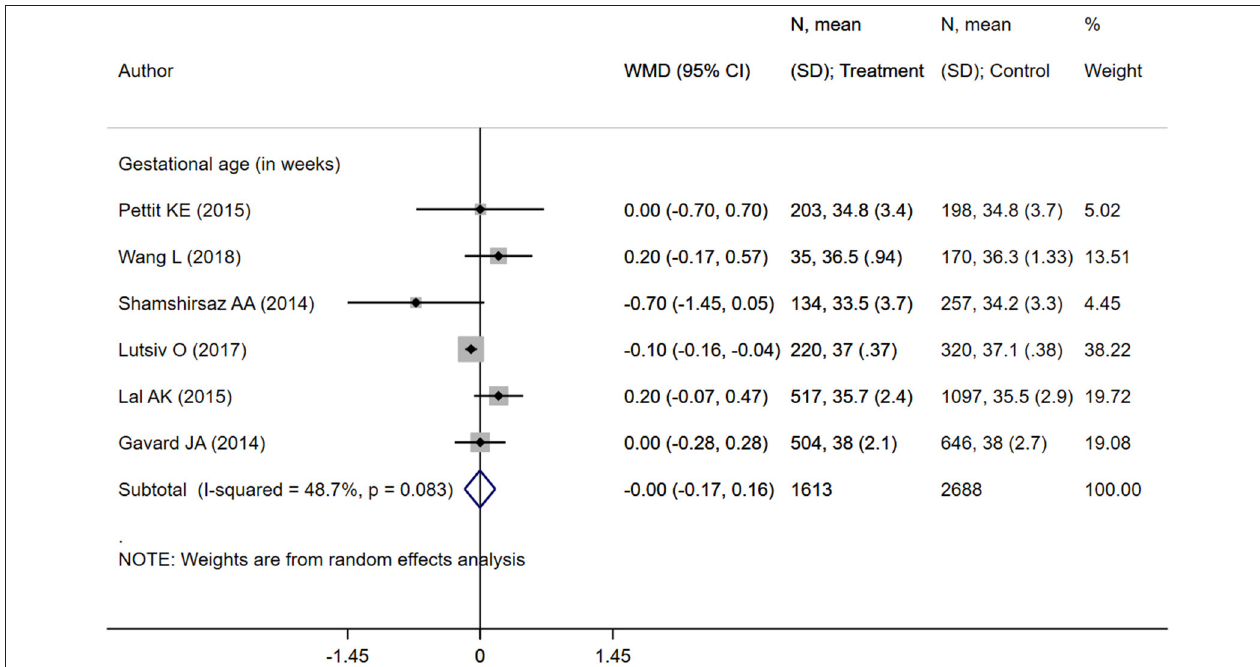
FIGURE 8 | Pooled analysis of excessive or adequate pregnancy weight gain effects on mean gestational age.